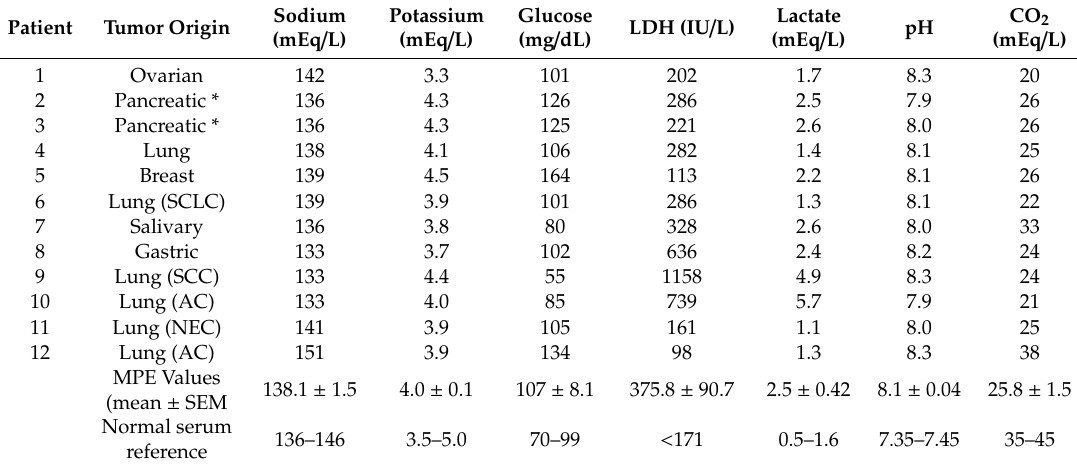
Figure 4. Acellular environment of MPEs is suppressive to CD8 + T cell function. CD8 + T cells were activated in the presence of anti-CD3 / CD28 microbeads and IFN γ was measured in culture supernatants by specific ELISA following 24 h co-culture with media, autologous peripheral blood monocytes or autologous non-hematopoietic MPE cells. ( a ) IFN γ production by CD8 + T cells is significantly reduced upon culture in 50% autologous acellular MPE fluid compared to cells culture in media, with monocytes, or non-hematopoietic MPE cells. ( b ) Spearman correlations between levels of free analytes detected in acellular MPE fluid. ( c ) Spearman correlations between levels of sodium, lactate, and LDH identified in patient MPEs with patient matched CD8 + T cell production of IFN γ in response to co-culture with autologous non-hematopoietic MPE cells. Table 3. Chemical analysis of acellular MPE fluid.